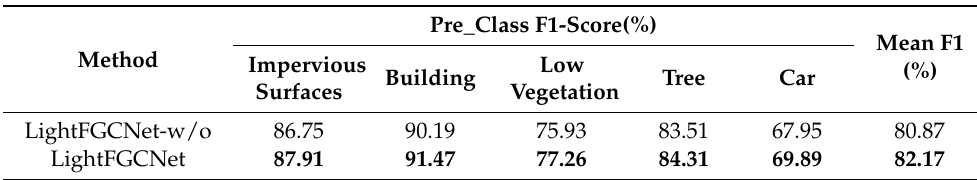
Table 3. Ablation study of the multi-scale fusion module, the w/o indicates no MSFM. The bold indicates the best